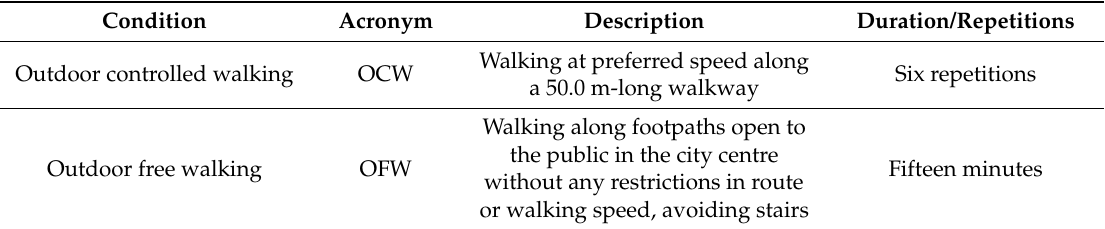
Table 1. Summary of the walking conditions performed during the experiments, with the acronym, description, and duration or